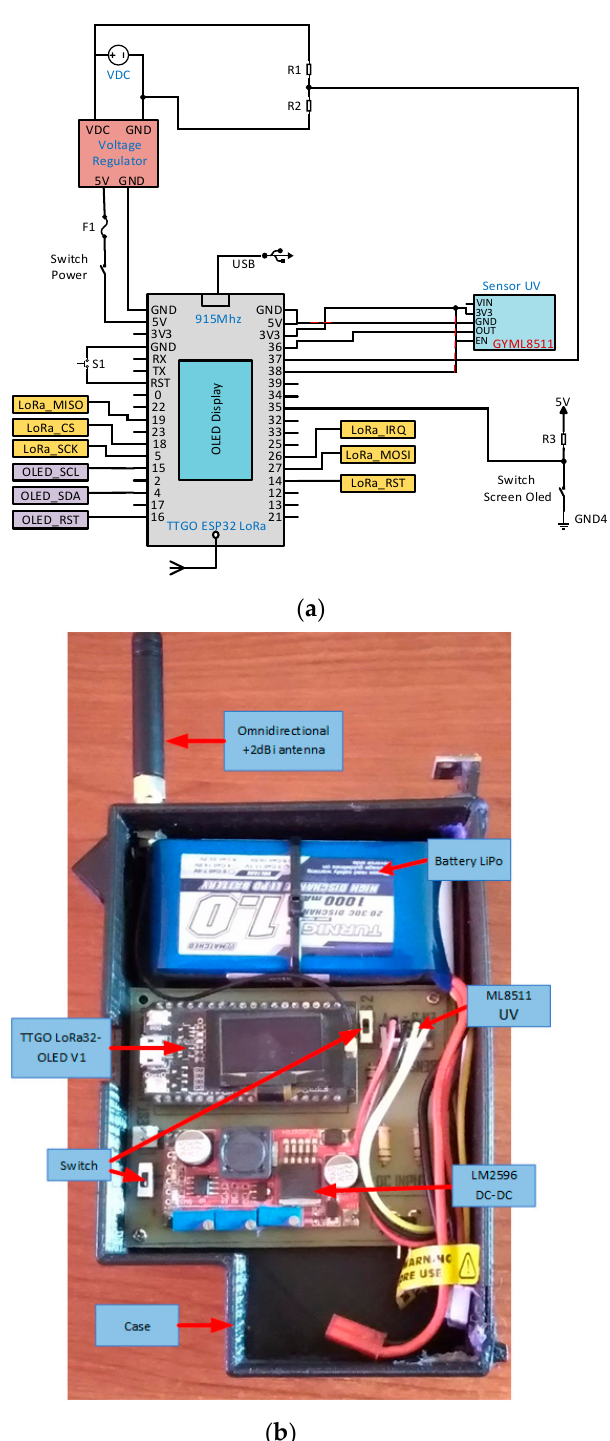
Figure 4. ( a ) Electronic schematic and ( b ) manufacturing of transmitter node 2.